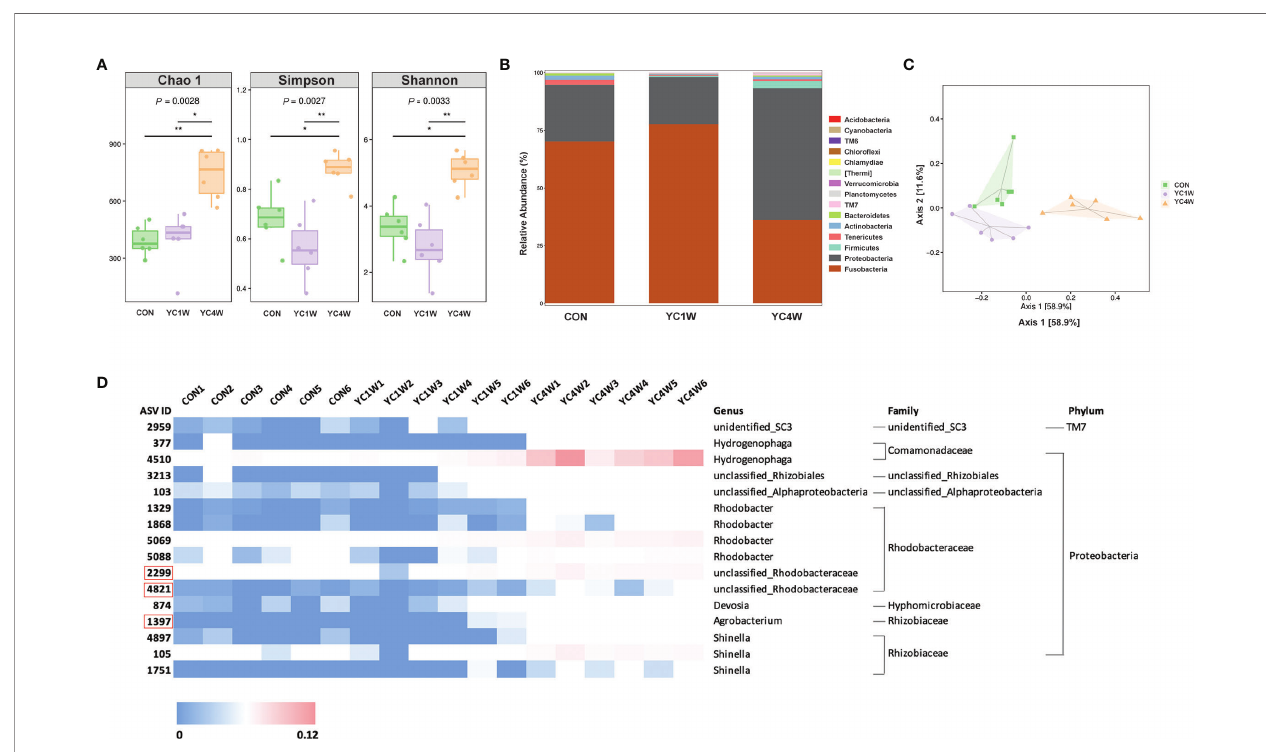
FIGURE 2 | Administration of P. pentosaceus YC for 4 weeks alerts gut microbiota composition. 16S rRNA gene sequencing of zebra fi sh intestinal contents from each group ( n = 6). (A) Alpha diversity metrics, p -values were identi fi ed with Kruskal – Wallis rank sum test. (B) Gut microbiota community of each group at the phylum level. (C) Principal coordinate analysis (PCoA) based on Bray – Curtis dissimilarity matrices to show beta diversity among groups at ASV level. (D) Heatmap analysis of 16 signi fi cantly changed ASVs in the YC4W group compared with the CON and YC1W group. The color bar of each ASV in each treatment is shown. The taxonomy of the ASVs (genus, family, and phylum) is described on the